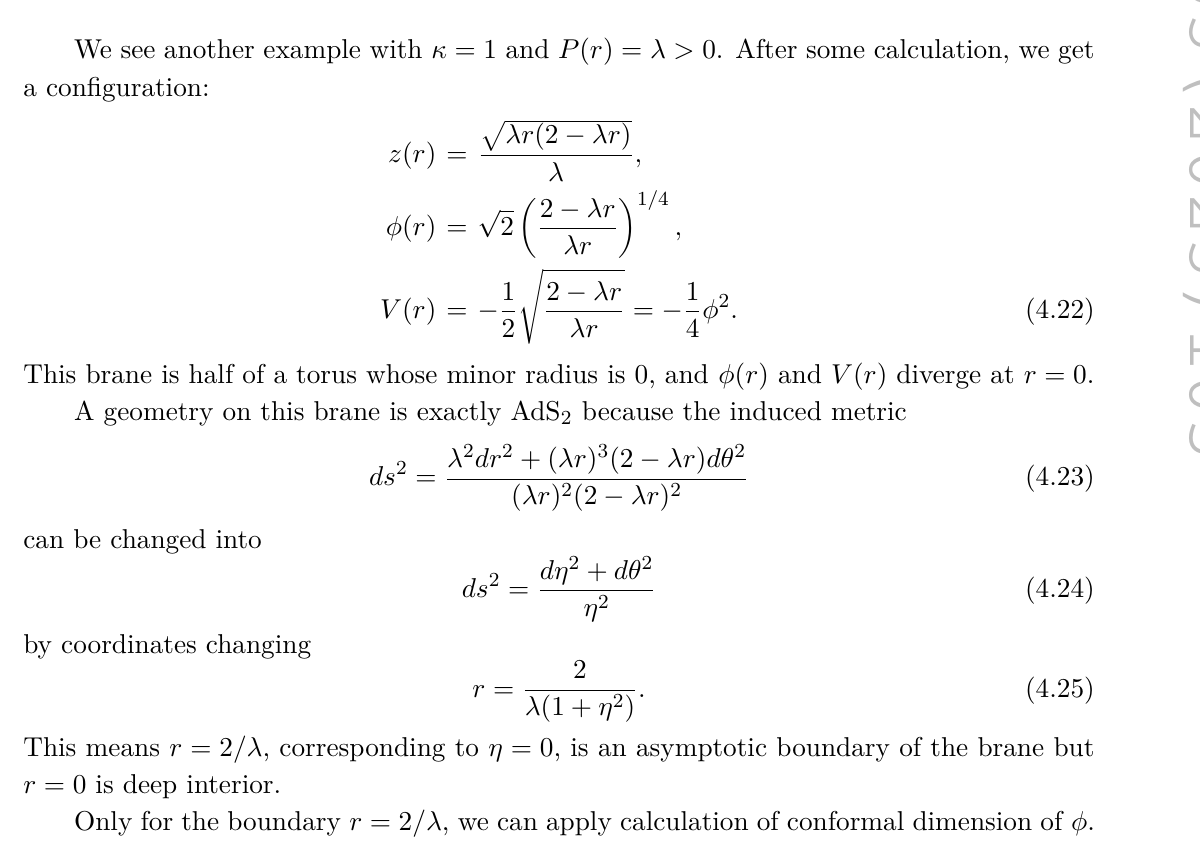
Figure 14 . The configuration of (4.22). The dual BCFT region is a disk with radius 2 /λ removed its center and the induced metric on brane is exact AdS 2